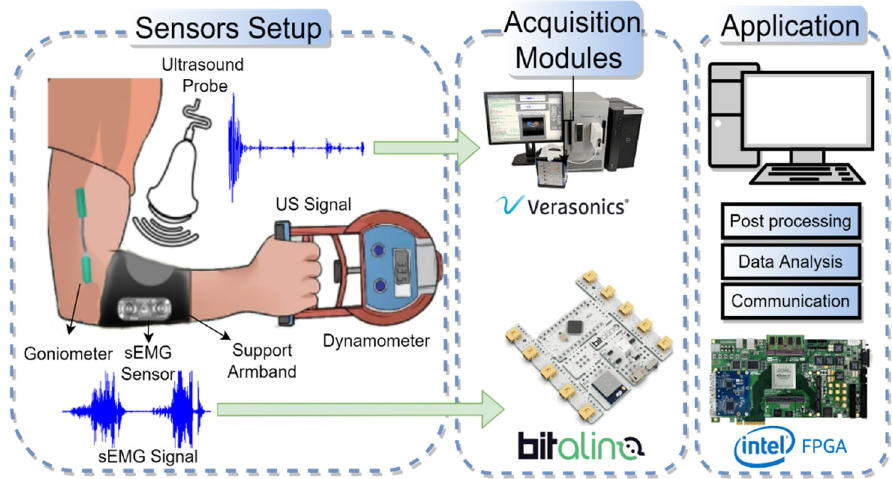
Figure 5. Multi-sensing model for data acquisition with Verasonics and Bitalino interfaces, based on sEMG and ultrasound.